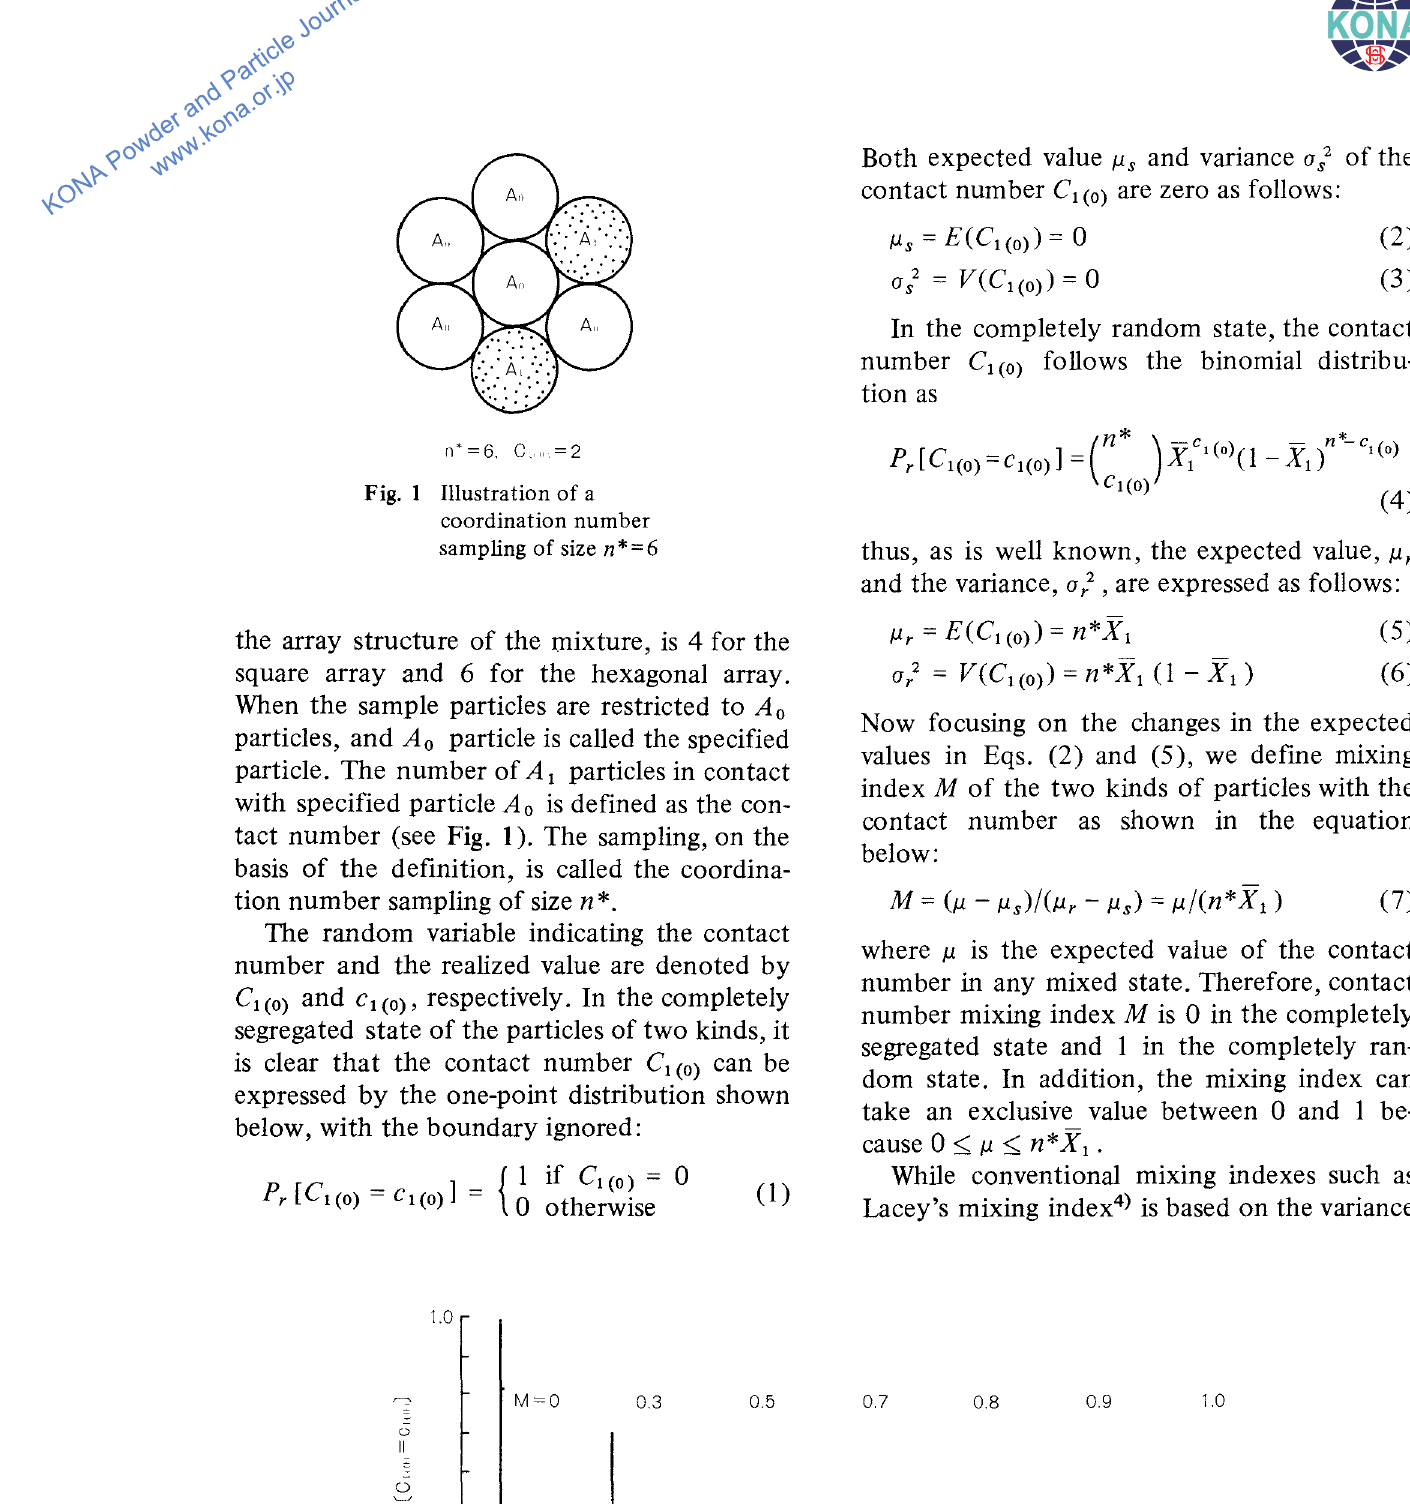
Fig. 2 Distribution of the contact number and the mixing index M with the total coordination number n*=4 and the population concentration X